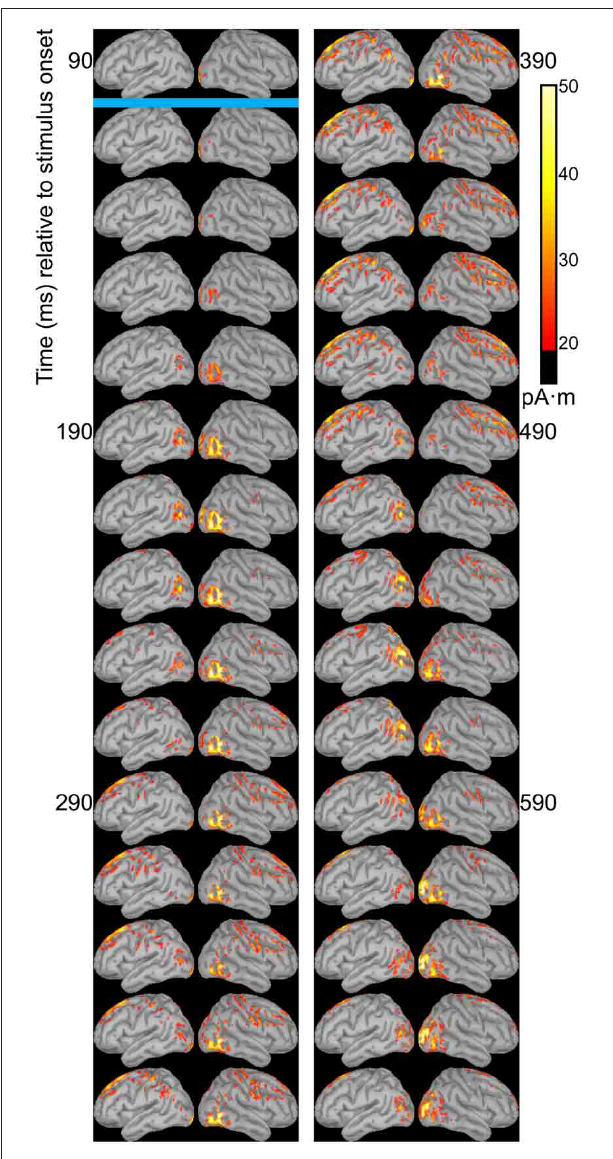
FIGURE 4 | Source images for “fa” standard. Images show the depth-weighted minimum norm estimate of dipole source strength constrained to the surface of the cortex using a boundary element forward model and a generic anatomical model at 20-ms intervals starting from 90ms after onset of visible motion for the group mean ERPs for syllable “fa” as standard . The time indicated by the cyan bar indicates the time at which “fa” visibly differs from “zha.” Images are thresholded at 20pA · m. Initial activity is in the occipital cortex. At 150ms after syllable onset, the bilateral posterior temporal activity begins that lasts until 290ms in the left hemisphere and until 490ms in the right hemisphere. Activation in the right posterior temporal cortex is more widespread and inferior to that on the left. Fronto-central activity is visible from 250 to 510ms post-stimulus onset.